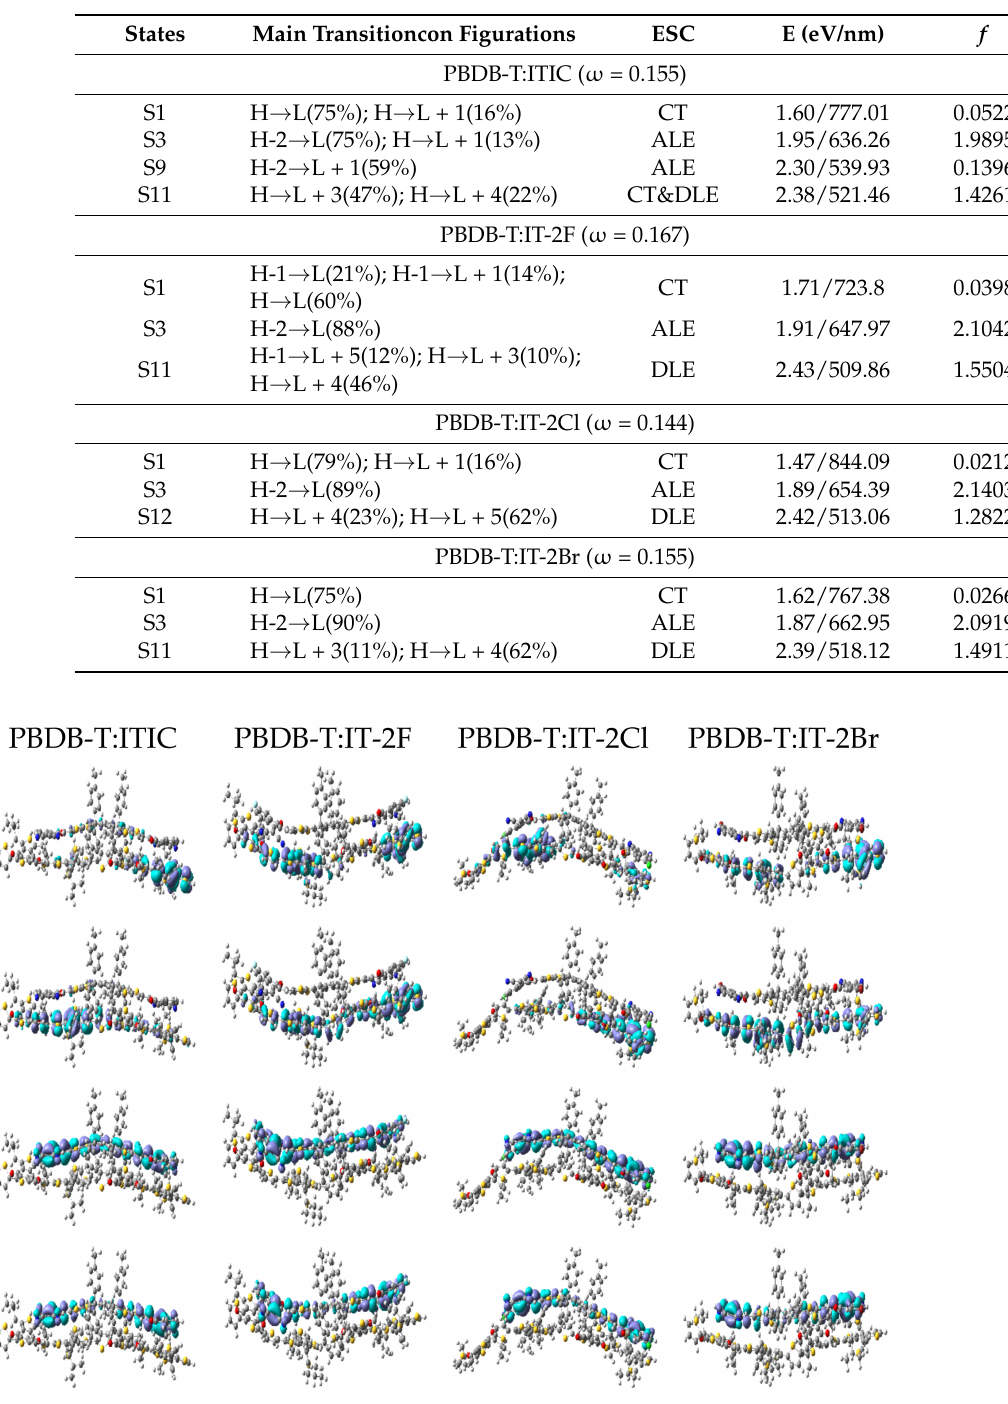
Figure 6. The selected frontier molecular orbitals for PBDB-T:ITIC and PBDB-T:IT-2X (X = F, Cl, Br) complexes. (LC-PBE/6- 31G**, ω = 0.155, 0.167, 0.144, 0.155 Bohr − 1 ; α = 0.200, β = 0.086; ε s = 3.5, ε d = 3.3; H = HOMO, L =